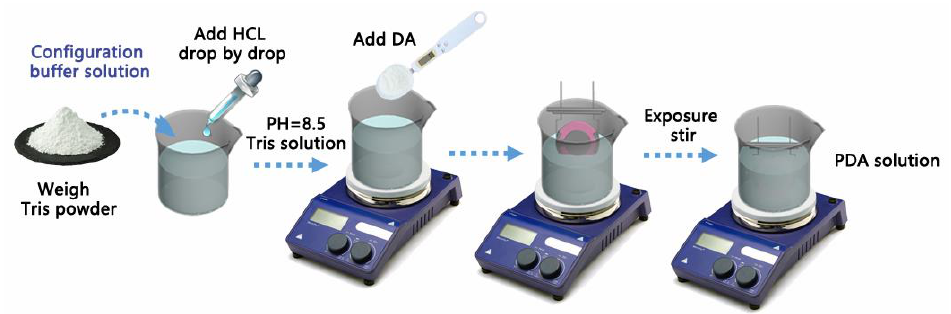
Figure 2. The schematic diagram of material synthesis and QCM humidity sensor fabrication by in situ method.